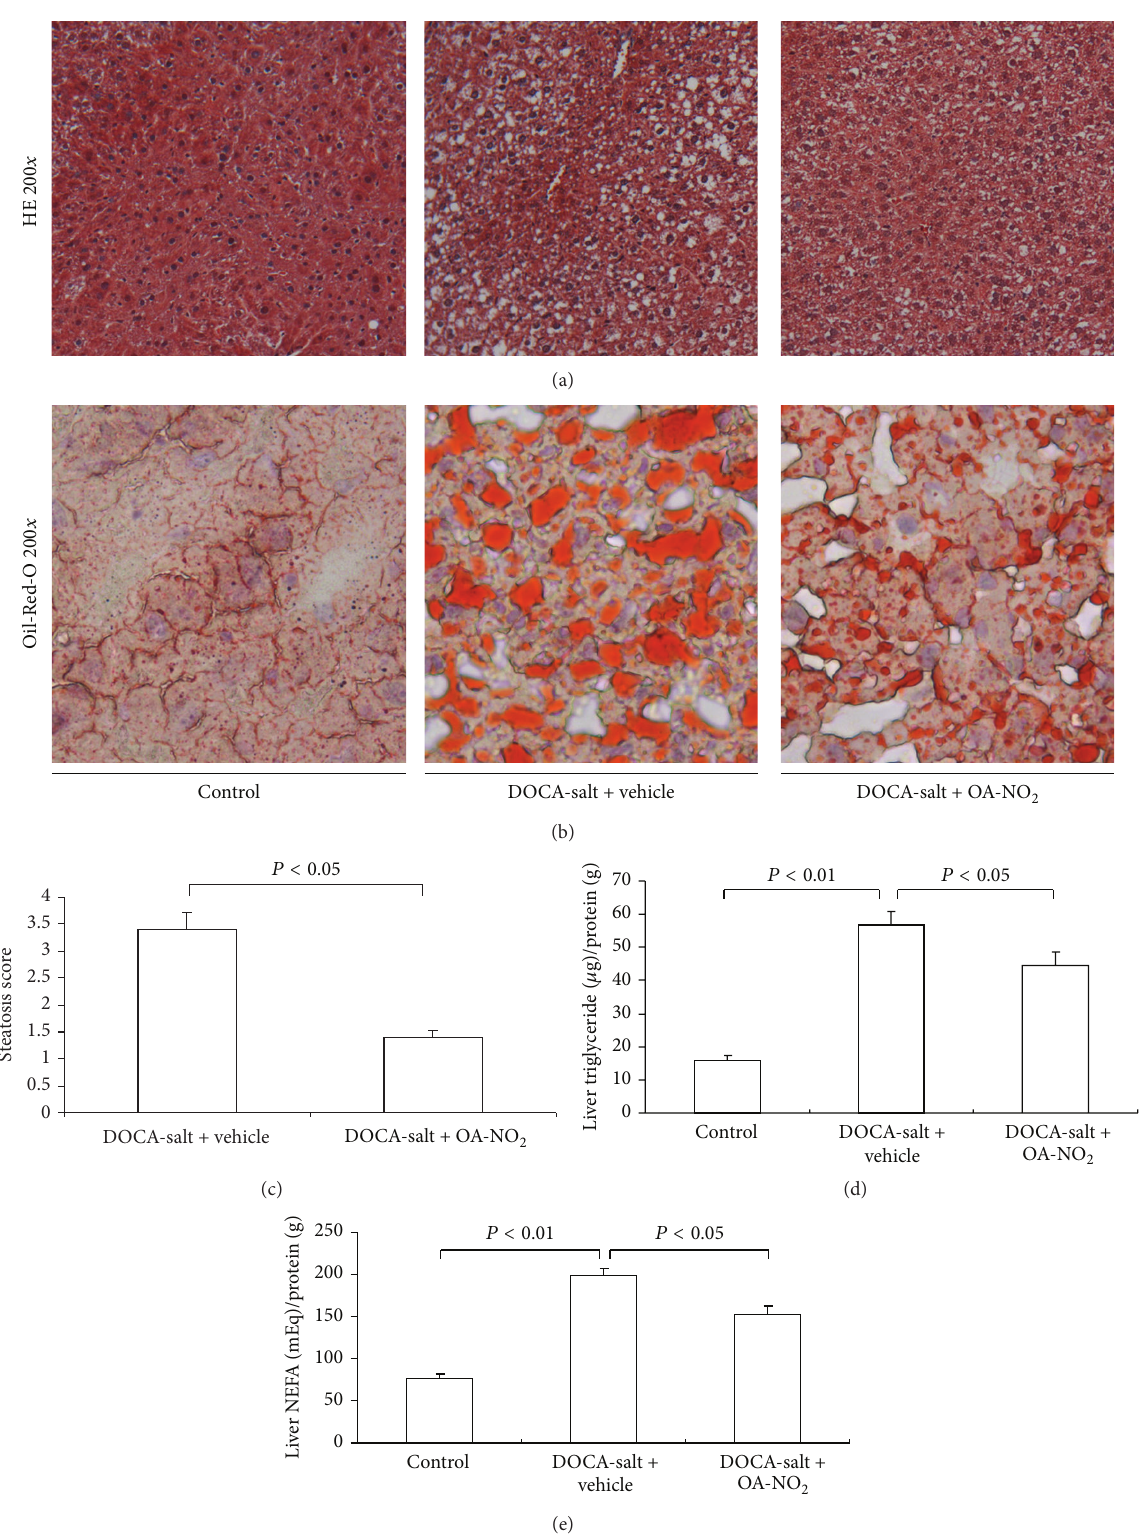
Figure5: Effect ofOA-NO 2 ontheliver steatosisafter 3-week DOCA-salttreatment. Morphological analysis of DOCA-salttreated liver injury in control, DOCA-salt + vehicle, and DOCA-salt + OA-NO 2 mice. (a) Representative photomicrographs: hematoxylin and eosin staining (magnification 200). (b) Oil-Red-O staining (magnification 200) of livers. (c) Mean liver steatosis score. The lipid content in liver: liver triglyceride (d) and liver NEFA (e). Control: 𝑛 = 5 ; DOCA-salt + vehicle: 𝑛 = 8 ; DOCA-salt + OA-NO 2 : 𝑛 = 8 . Data are shown as mean +